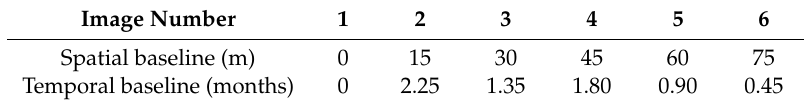
Table 1. The baseline information of the simulated